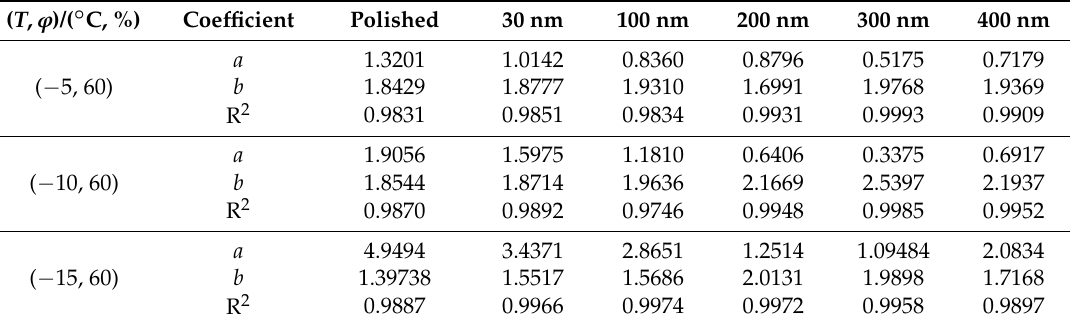
Table 5. Polynomial model coefficients and regression formula correlation.